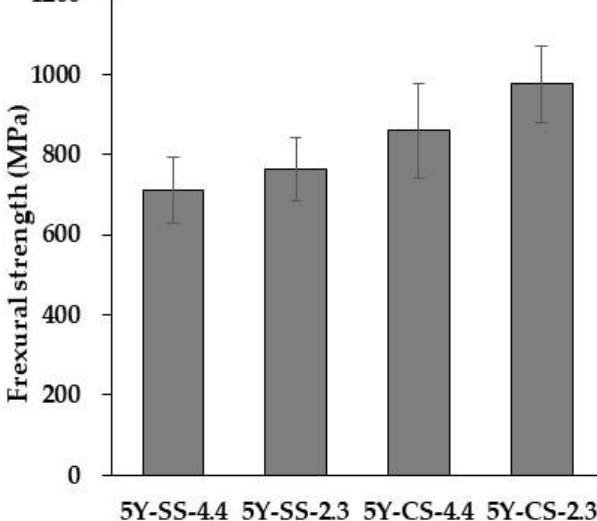
Figure 12. Tree-point flexural strengths of 5Y-SS and 5Y CS.